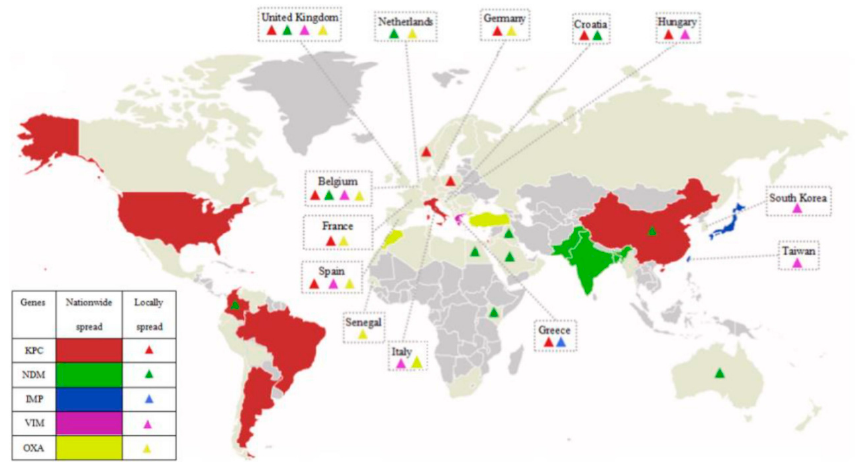
Figure 1. Global distribution of carbapenem-resistant Enterobacteriaceae (CRE). Adapted from Cui et al.